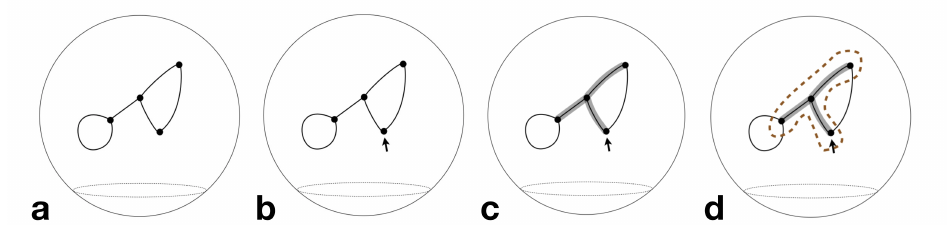
Figure 3. Tree-rooted plane graphs: ( a ) A plane graph, ( b ) a rooted plane graph, ( c ) a tree-rooted plane graph, ( d ) Mullin’s encoding of a tree-rooted plane graph: Starting from the root arrow and proceeding counterclockwise around the dashed contour, the encoding is ‘ ([[)][()]]